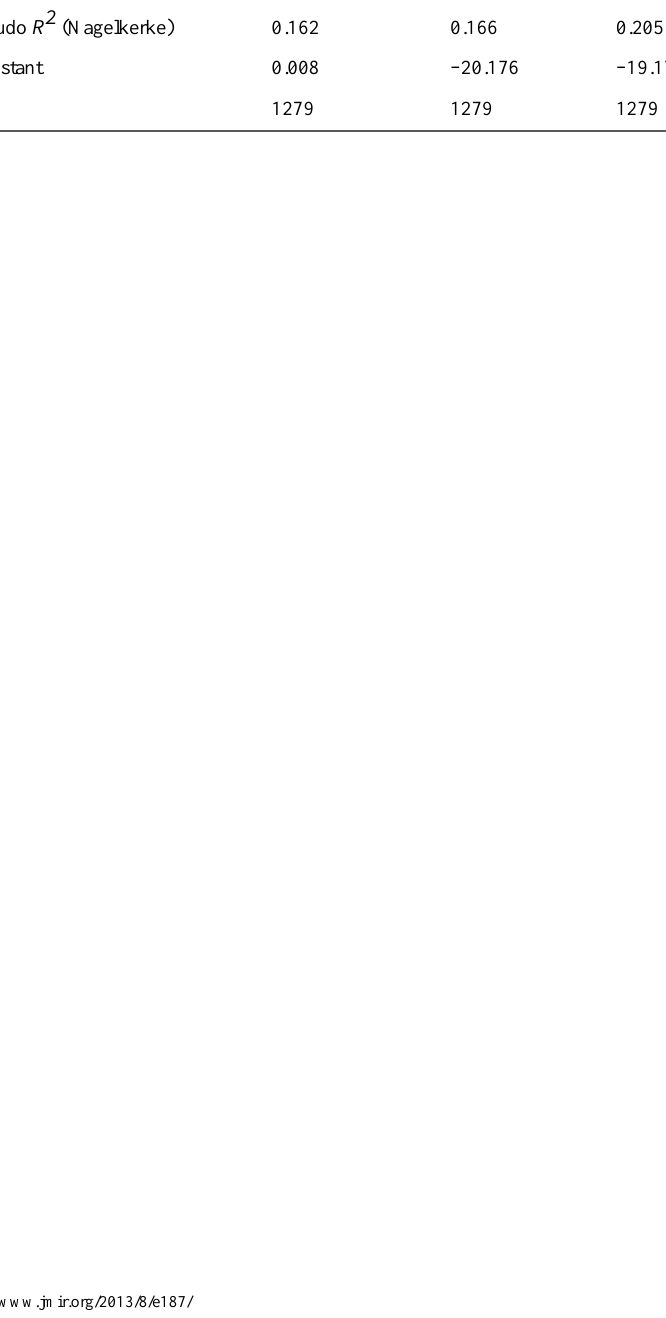
Negative impactPositive impactRatingSearchingAwarenessStatistical